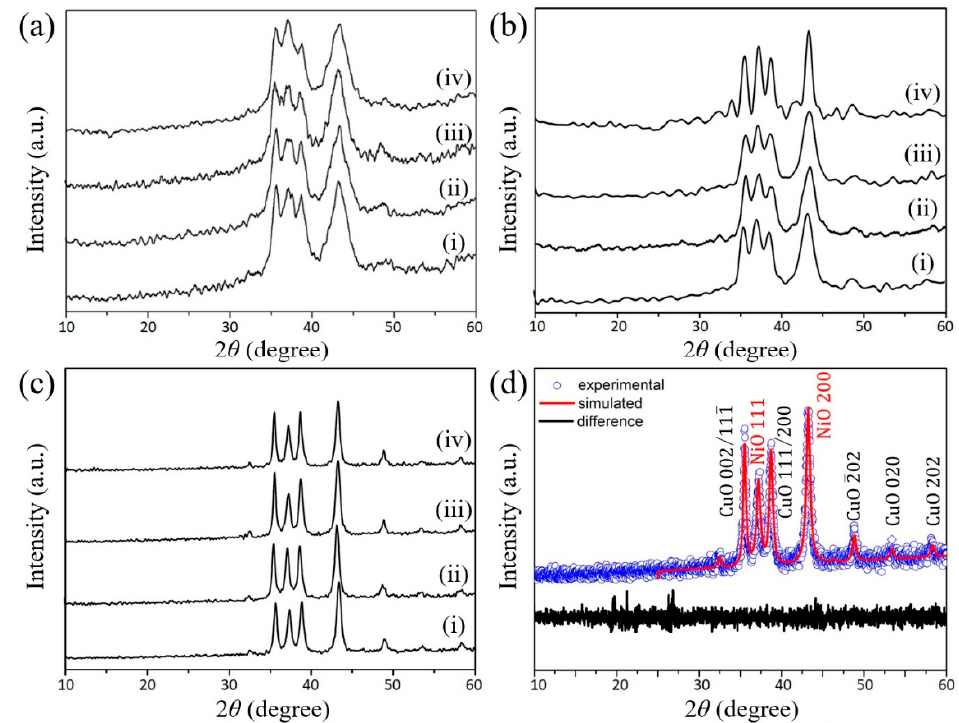
Figure 4. Wide-angle XRD patterns of the calcined samples at various temperatures (( a ) 300 °C; ( b ) 400 °C and ( c ) 500 °C) of ( i ) Cu-Ni_0.00, ( ii ) Cu-Ni_0.15, ( iii ) Cu-Ni_0.20 and ( iv ) Cu-Ni_0.25; ( d ) Powder XRD pattern of Cu-Ni_0.20_500 and refinement by the Pawley method.